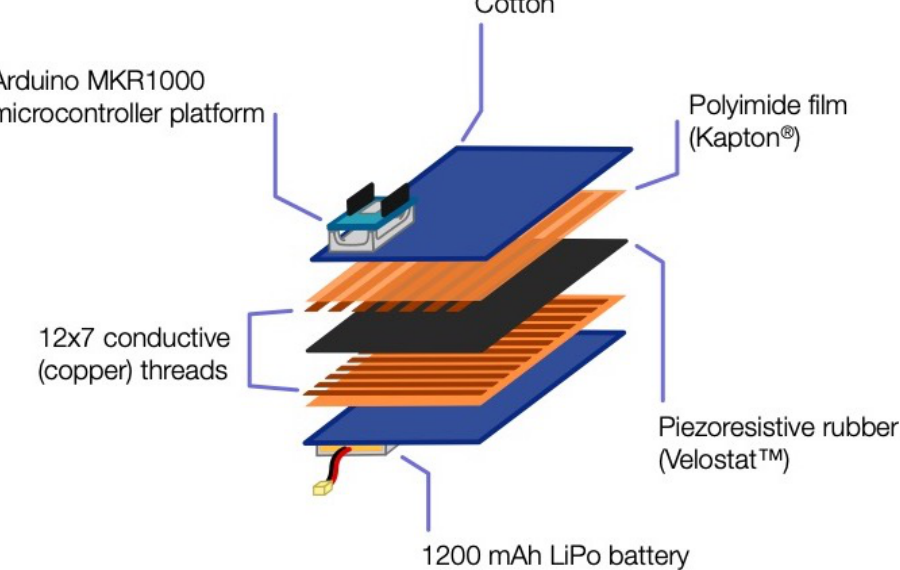
Figure 2. Exploded-view drawing of the textile with integrated tactile sensing. Conductive threads organized in a 12 by 7 grid are applied on piezoresistive rubber, creating a variable resistor. The resulting voltage acts as a proxy for local forces applied on the